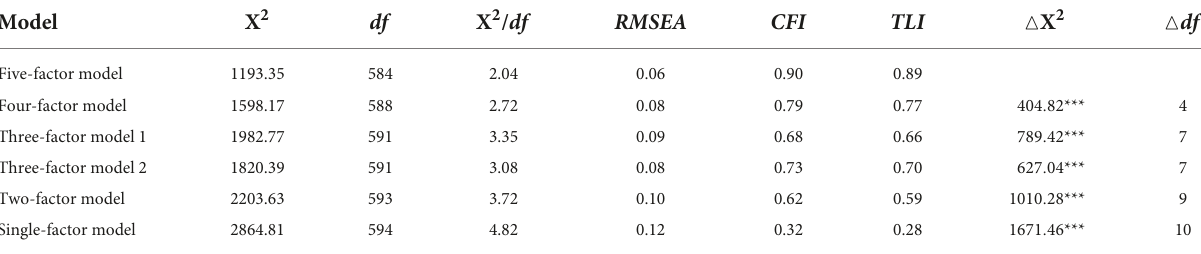
TABLE 1 Model comparison.